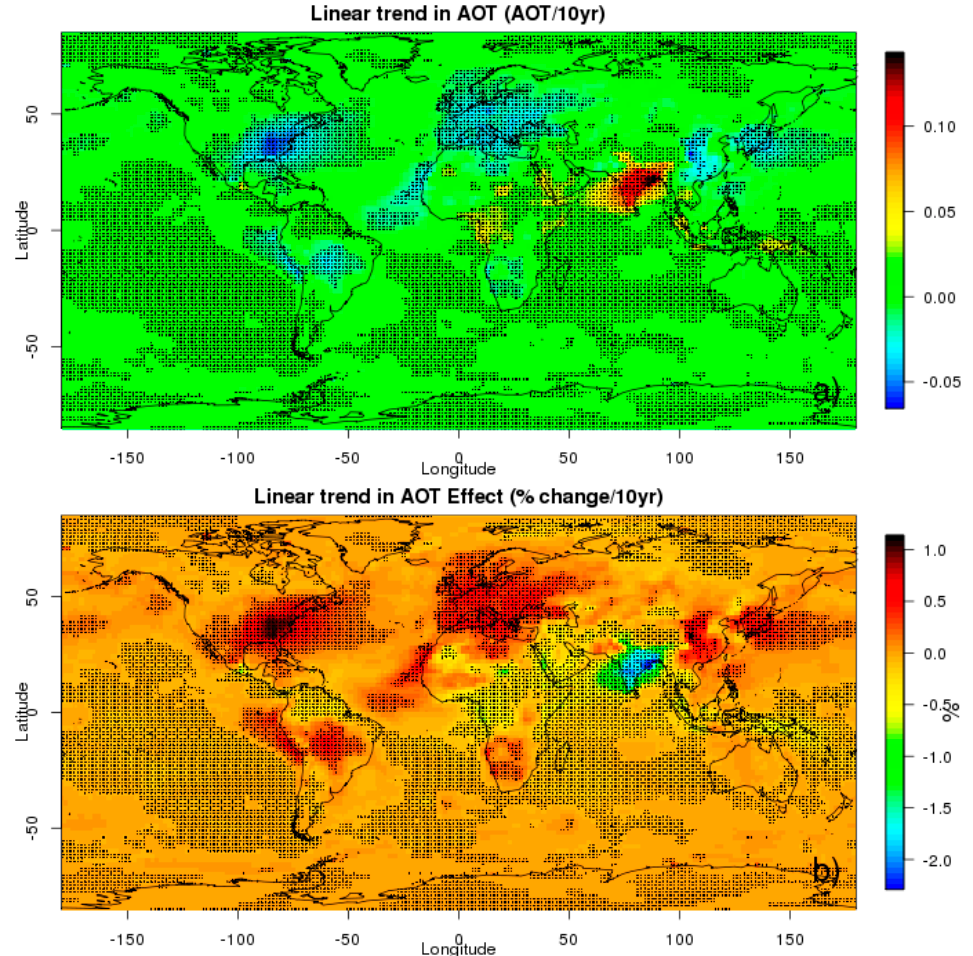
Figure 11. Global spatial distribution of linear trend per decade (AOT ( a ) and AOT effect ( b )). Pixels with levels of significance p < 0.05 are marked with a black